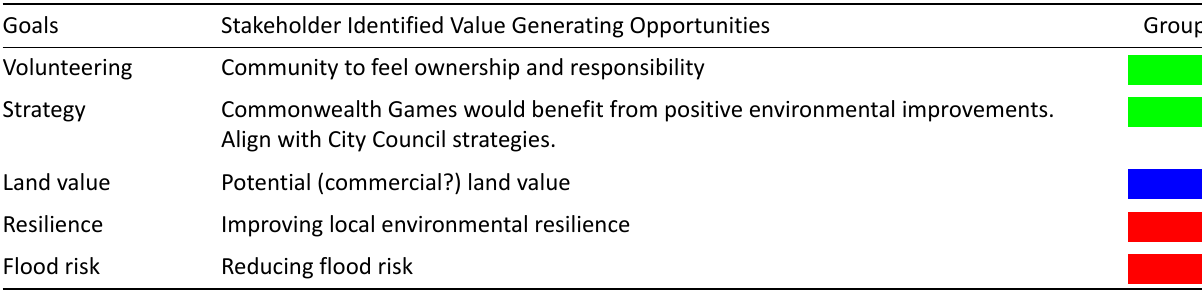
Table 5. Lower priority value-generating opportunities identified by the four stakeholder